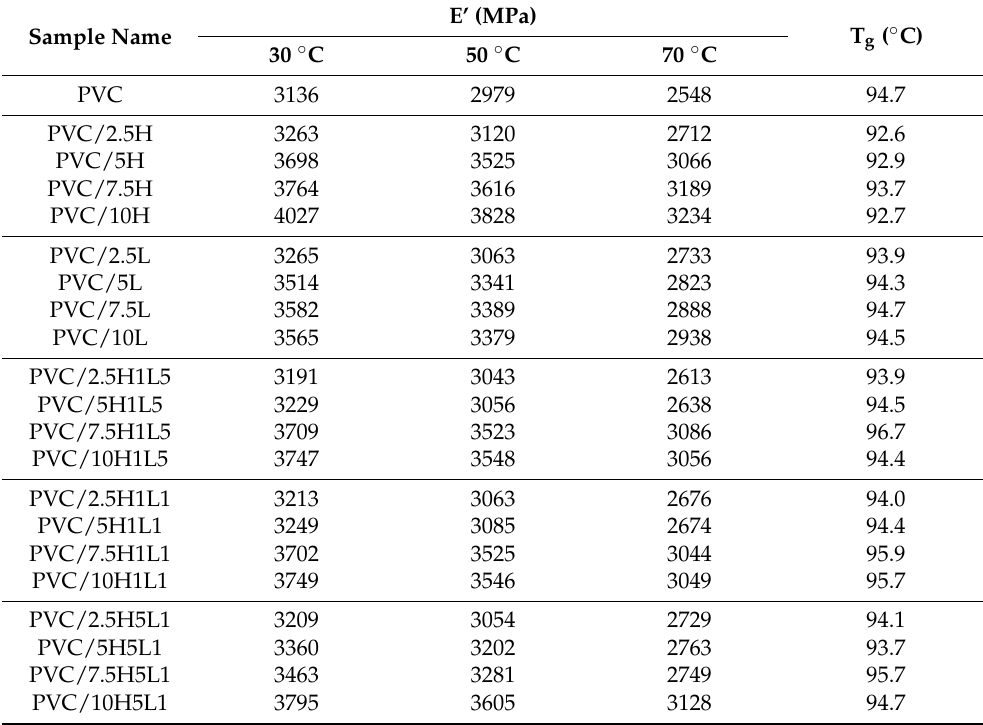
Table 4. The storage modulus (E’) and glass transition temperature (T g ) of PVC and PVC